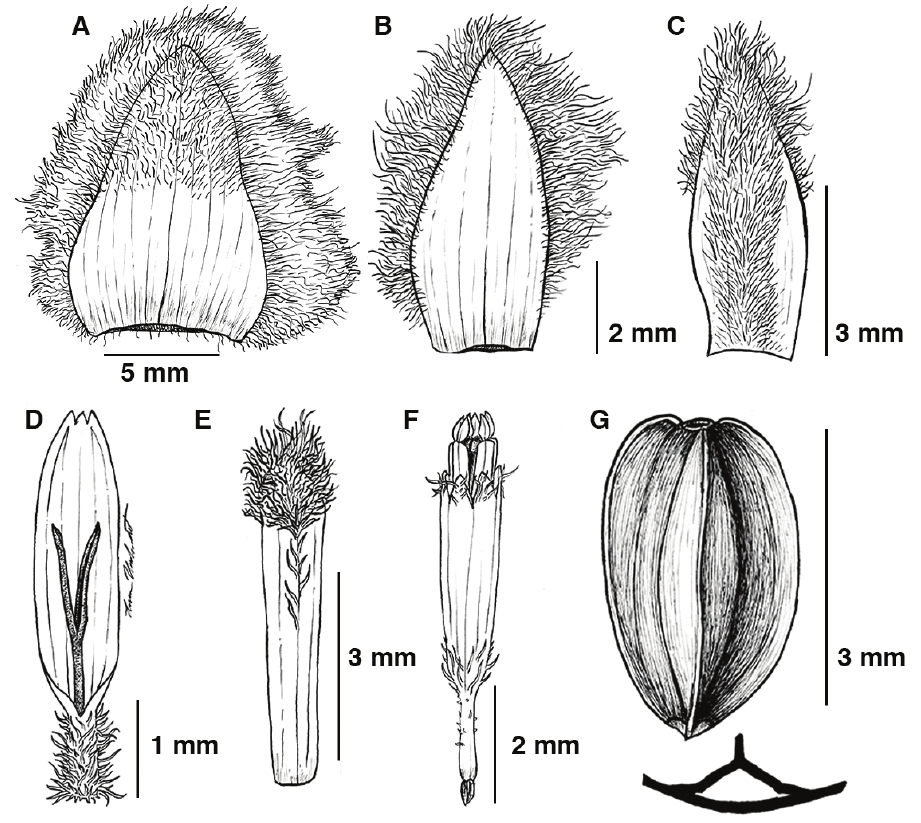
Figure 2. Illustrations of Espeletia praesidentis . A outer phyllary B Inner (sterile) phyllary C ray flower palea D ray flower E disc flower palea F disc flower G dorsal view of cypselae from ray flower. Illustrations made by Lauren